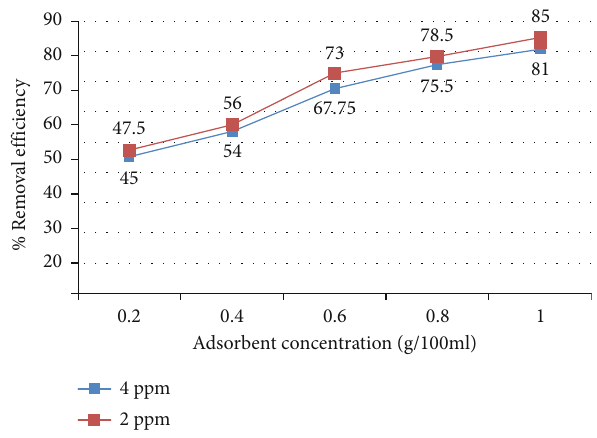
Figure 4: Coconut husk adsorbent with initial fl uoride concentration 2ppm and 4 ppm.